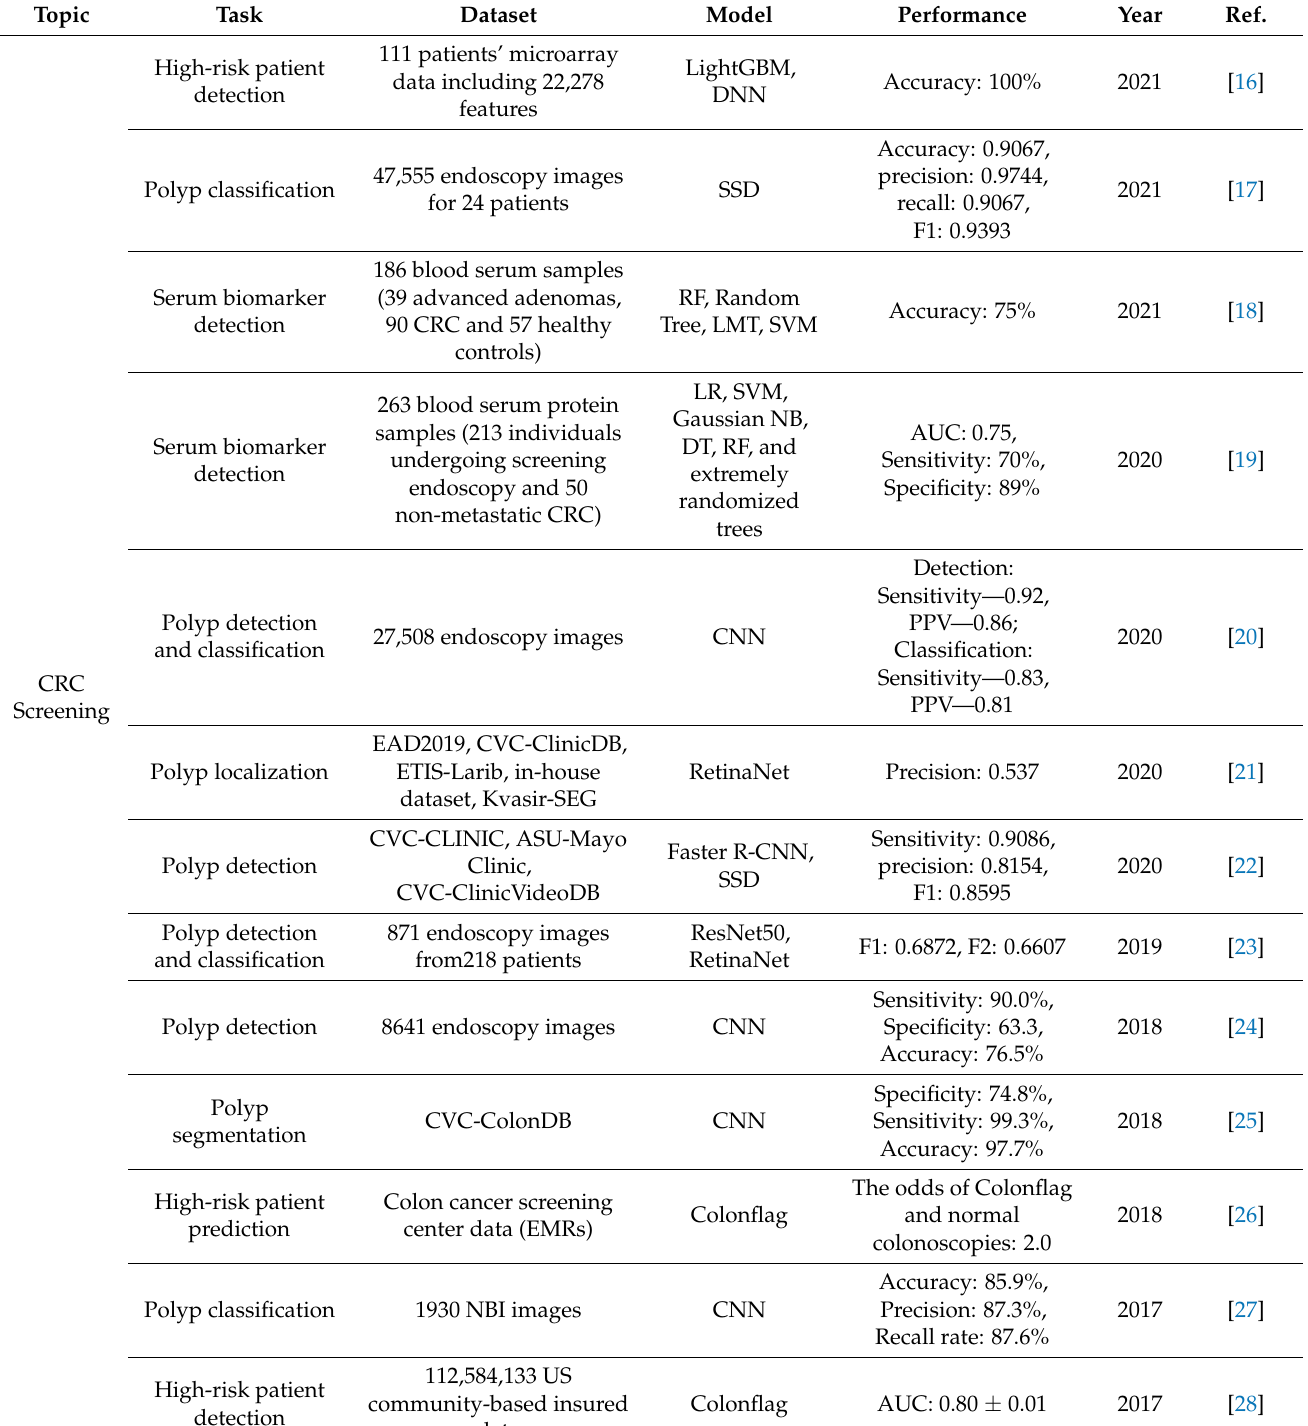
Table 1. Summary of AI applications for CRC screening. (DNN, deep neural network; SSD, single shot multibox detector; RF, random forest; LMT, logistic model trees; SVM, support vector machine; LR, logistic regression; NB, naïve Bayes; DT, decision tree; CNN, convolutional neural network; PPV, positive predictive value; Faster R-CNN, faster region-based CNN; AUC, area under the curve). Dataset Model Performance Year